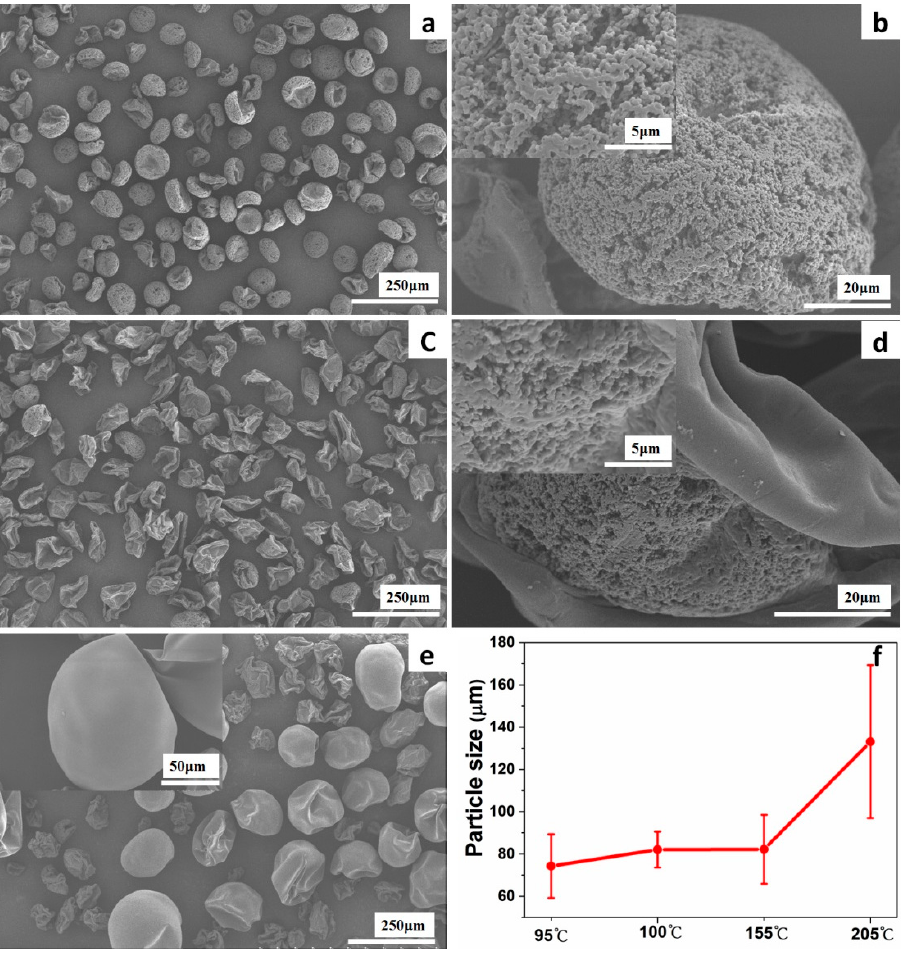
Figure 2. SEM images of the hydrocortisone-loaded microparticles obtained with an ethanol/water mixed solvent of 4:1 volume ratio at a drying temperature of 95 ( a , b ); 100 ( c , d ); and 205 °C ( e ), respectively; and the particle size variation trend ( f ) with increasing drying temperature.